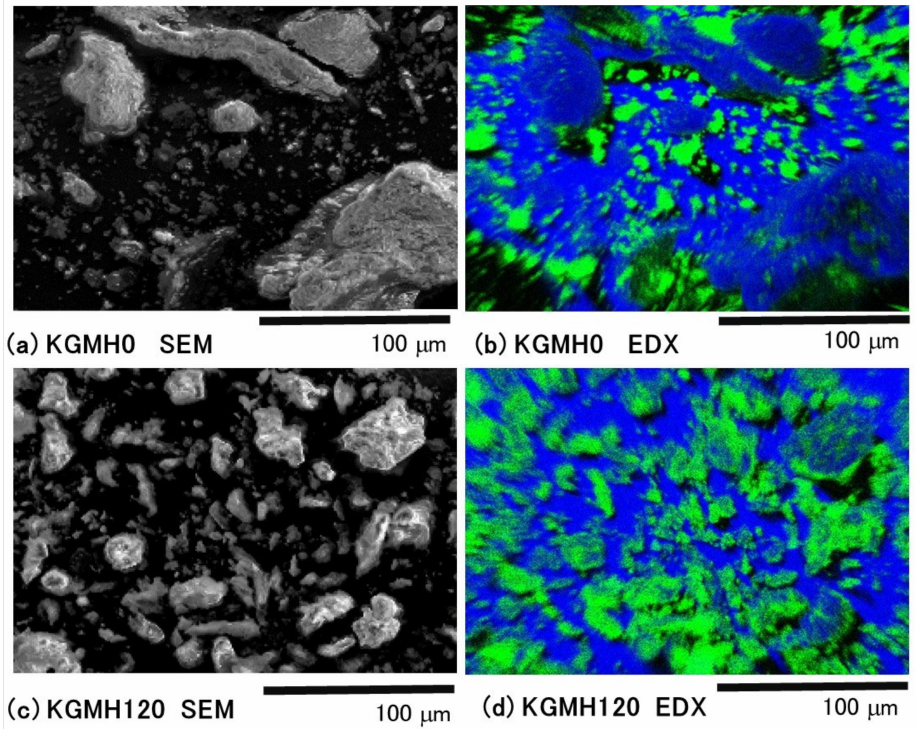
Figure 2. Scanning electron microscopy/energy-dispersive X-ray spectroscopy images of the KGMH0 and KGMH120 particles, respectively. SEM, scanning electron microscopy ( a , c ); EDX, energy- dispersive X-ray spectroscopy Ca (green) in EDX ( b , d